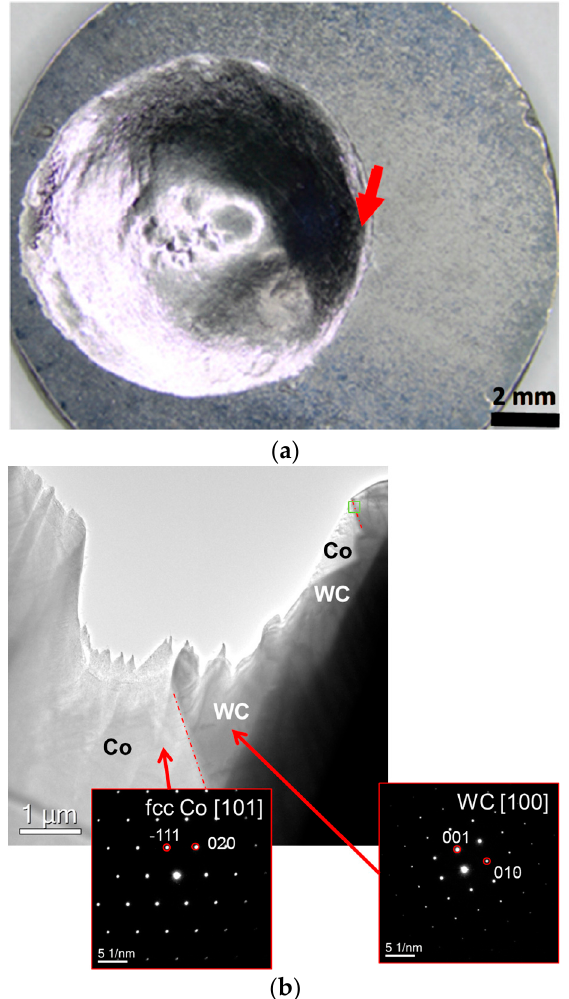
Figure 5. WC-Co interfaces in the sample that was obtained after melting the alloy with the high carbon content on the WC surface: ( a ) The sample appearance with an arrow indicating where a FIB lamella was cut off from the interface region (note that the sample is characterized by incomplete wetting); ( b ) Interface nano-structure with insets indicating SAED patterns.